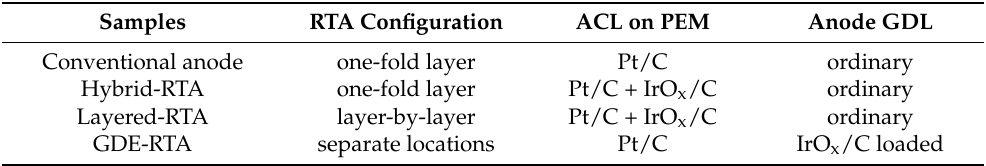
Figure 1. Schematic diagram for three types of MEA with different RTA configurations. Table 1. Detailed description of MEAs with different RTA configurations.